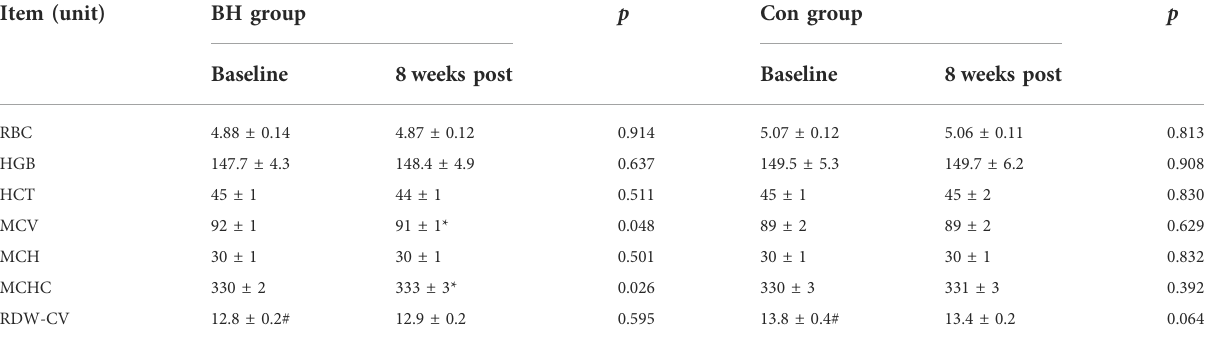
TABLE 2 Variations in red blood cells, haemoglobin and related